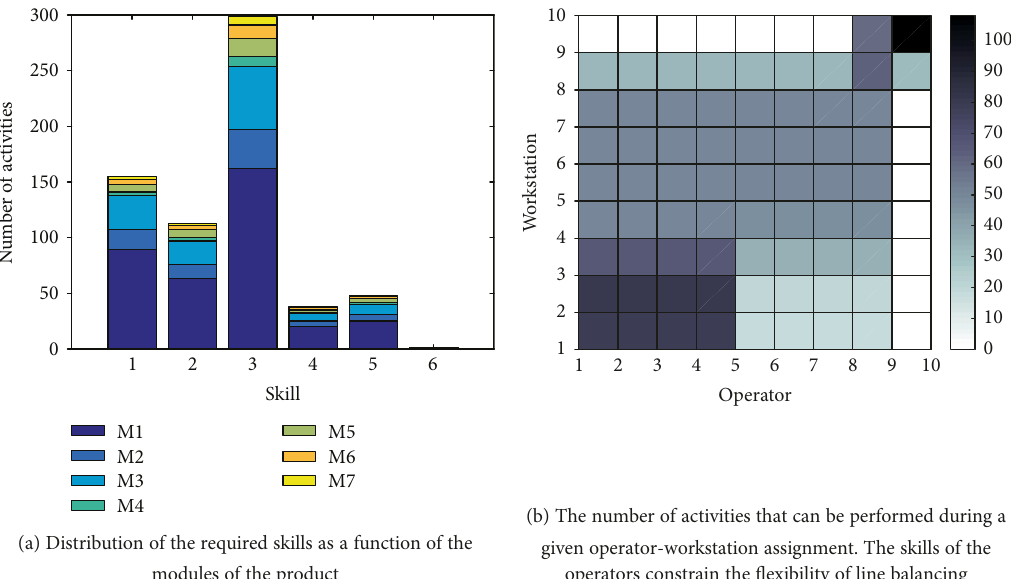
Figure 11: Analysis of the demand of skills and the fl exibility of the operator-workstation assignment.